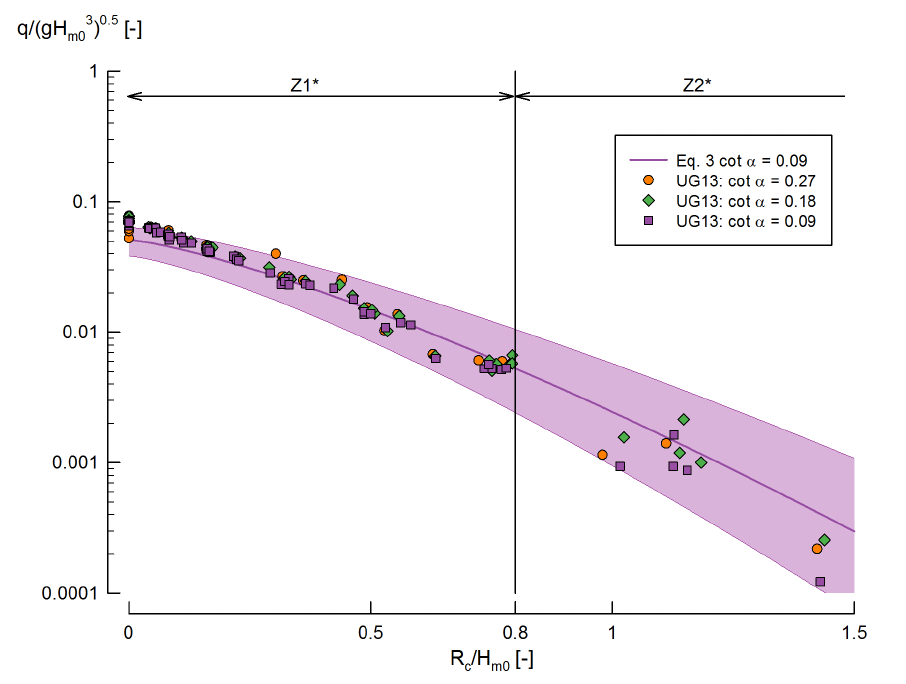
(cid:113) gH 3 as a function of the relative crest m 0